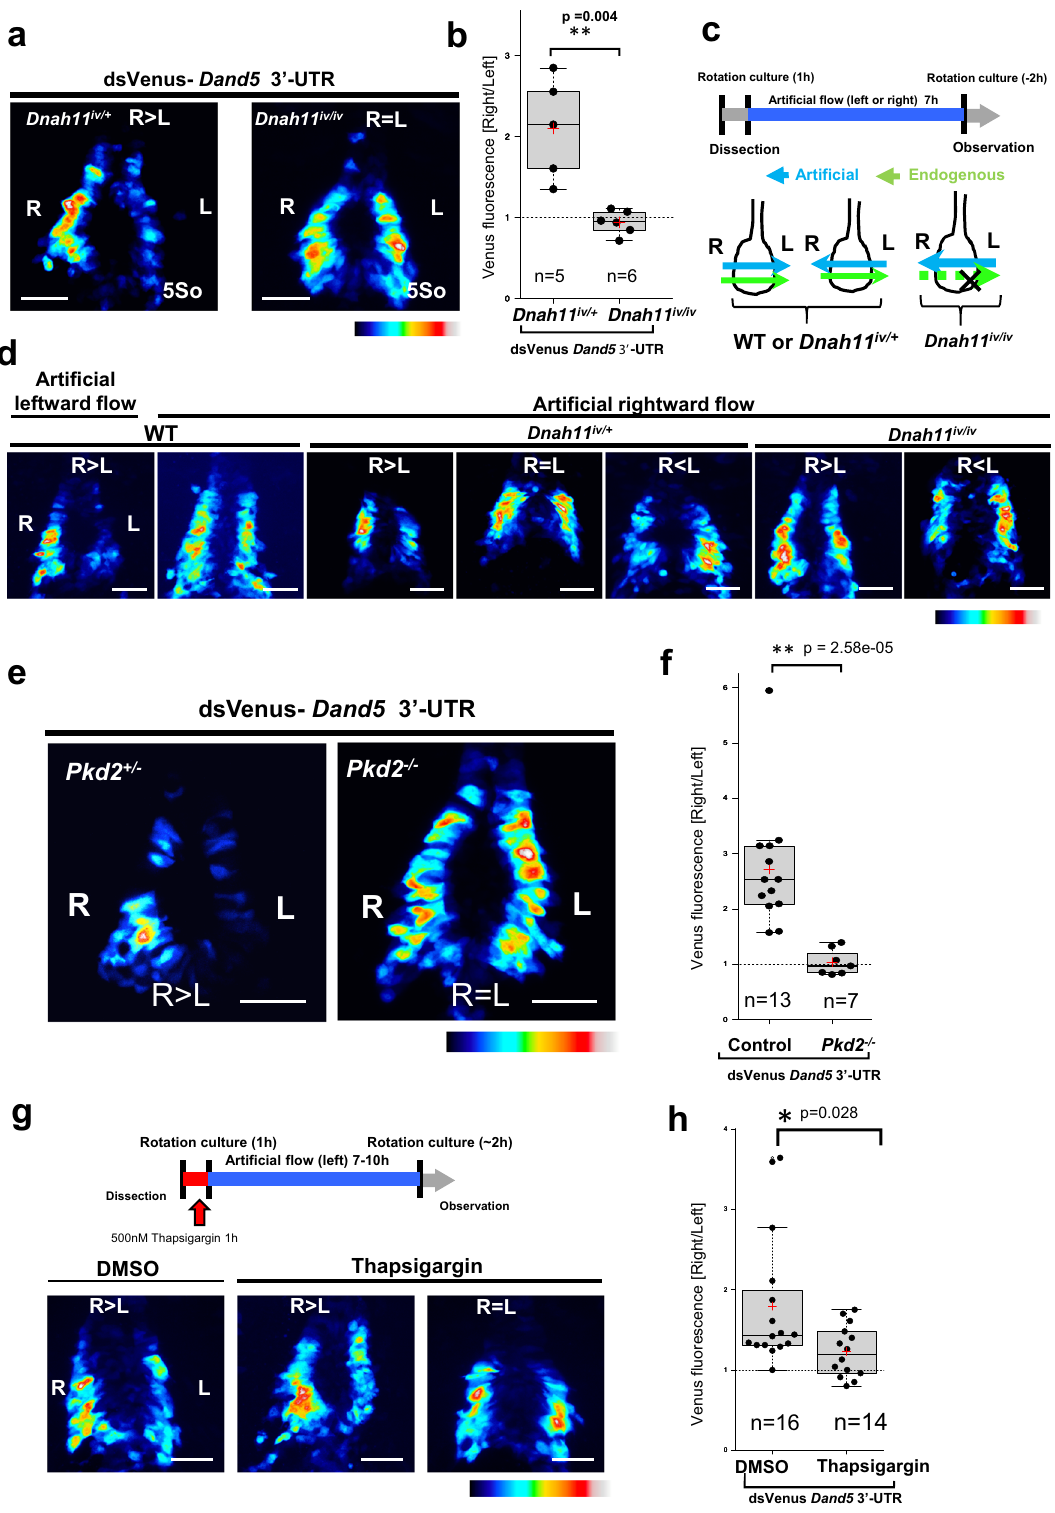
examined, one embryo lost Nodal expression in LPM, suggesting that the Dand5 Δ 200prox allele may act dominantly in rare instances. WISH analysis also showed that Dand5 mRNA was not distributed asymmetrically in Dand5 Δ 200prox/ Δ 200prox embryos ( n = 5/5) (Fig. 3d). Together, these results indicated that the 200- nucleotide proximal region of the 3 ′ -UTR is involved in the L-R asymmetric pattern of Dand5 mRNA in node crown